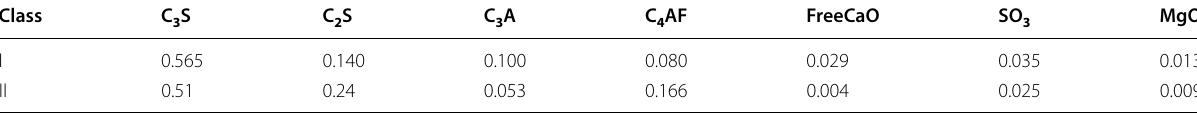
Table 1 Weight fractions of the components of cement classes I and II to the total cement ratio. Class C 3 S C 2